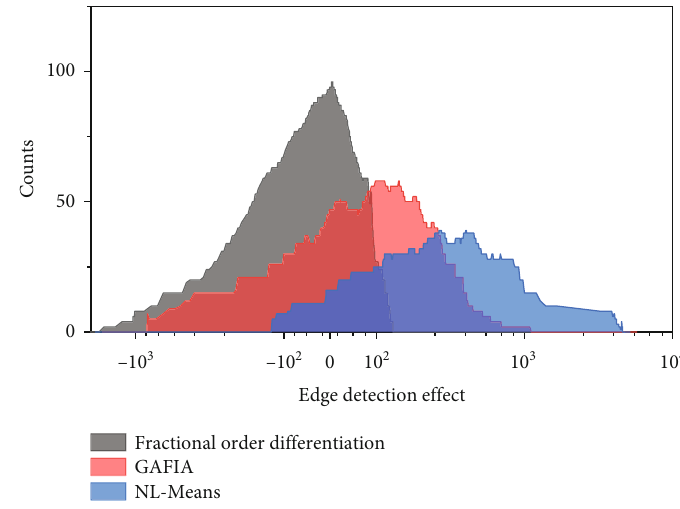
Figure 5: Comparison of the edge detection e ff ect of several classical edge detection algorithms.